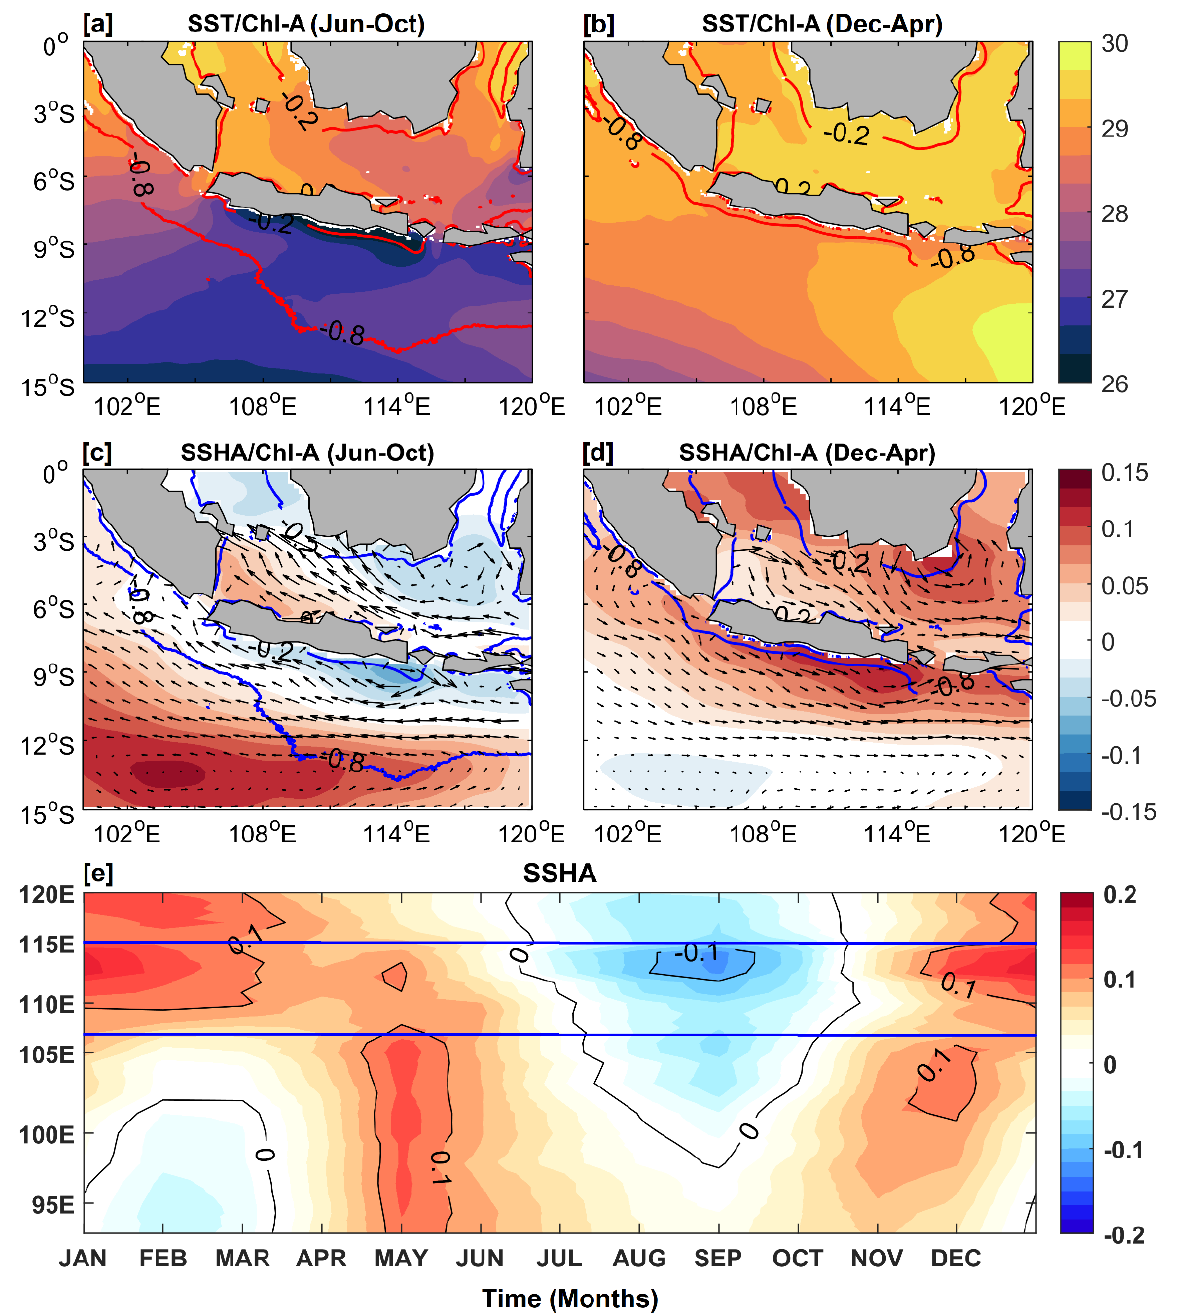
Figure 4. The seasonal variability of chlorophyll-a concentration (in mg m − 3 at logarithm scale) during ( a ) June–October and ( b ) December–April, overlaid with wind stress vectors (in N m − 2 ) during 2008– 2019. ( c , d ) Similarly, for wind stress curl (in × 10 − 7 N m − 3 ) overlaid by vectors of Ekman Mass Transport (in kg m − 1 s − 1 ) and red contours of chlorophyll-a concentration ( − 0.8 mg m − 3 in logarithm scale) during the same two seasons. ( e ) Latitude–time hovmöller diagram for climatological SSHA (in m). The latitudinal section has been taken along the track (orange color) shown in Figure 1. The region between the blue lines shows the SSHA variability along the Java coast.